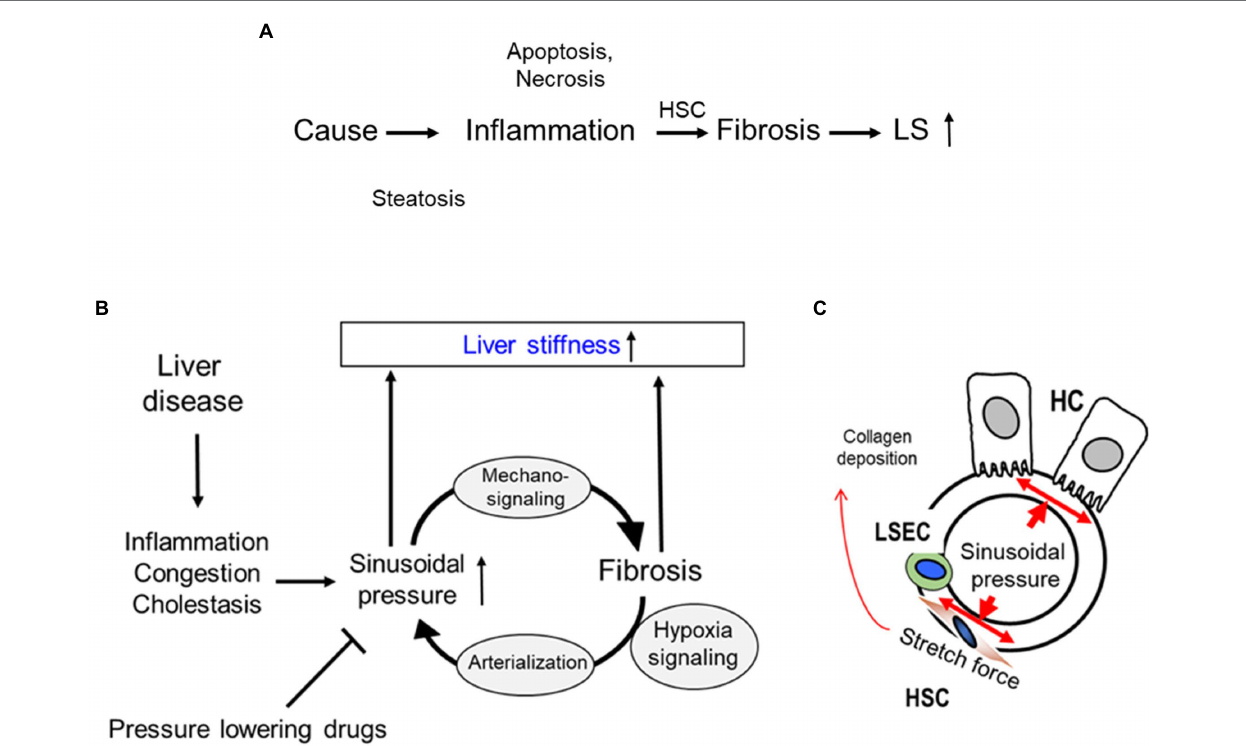
FIGURE 5 | Sinusoidial pressure hypothesis (SPH) at the organ and cellular level. (A) Conventional sequence of events during fibrosis progression with elevated liver stiffness (LS) mostly seen as a final consequence of matrix deposition. HSC, hepatic stellate cells; LS, liver stiffness. (B) All liver pathologies cause sinusoidal pressure (SP) elevation that ultimately drives fibrosis through mechano-signaling. A sustained pressure elevation ultimately causes arterialization of the liver via hypoxia signaling. SPH identifies arterialization as point of no return for liver progression and is able to explain macroscopic changes. Moreover, within the concept of SPH, pressure-lowering drugs could not only be used to treat complications of cirrhosis such as portal hypertension but causally to interrupt the vicious cycle by lowering the sinusoidal pressure. (C) According to SPH, SP predominantly translates into mechanic stretch forces within the perisinusoidal bed. Hepatocyte cell death, inflammation, or congestion all lead to increased SP that causes stretching of e.g., HSC, liver sinus endothelial cells (LSEC), or